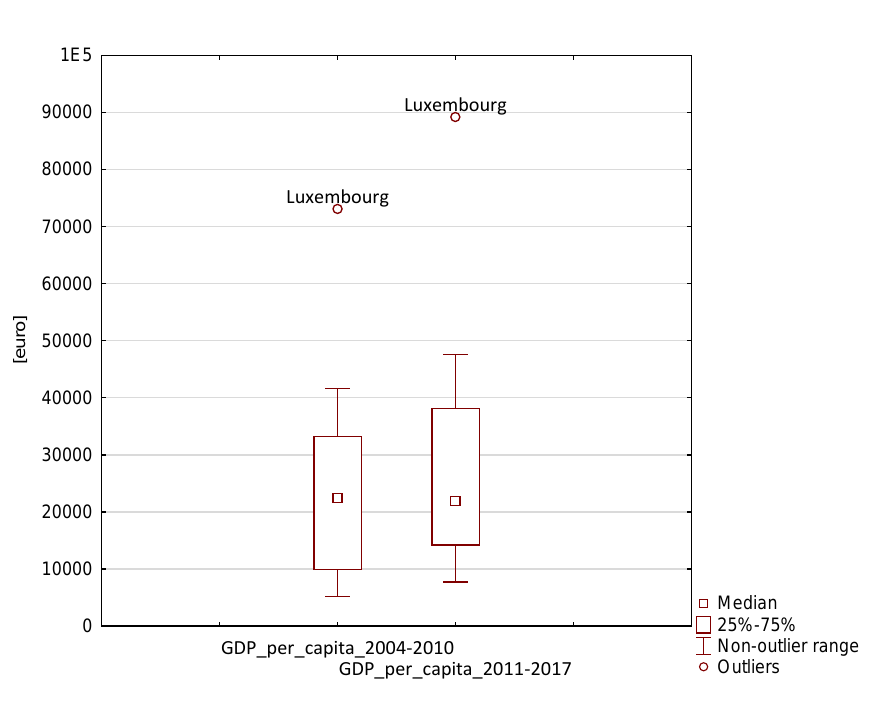
Figure 2. Empirical distribution characteristics of per capita GDP in the EU member states in 2004-2010 and 2011-2017. Source: author’s own study carried out using the ‘STATISTICA’